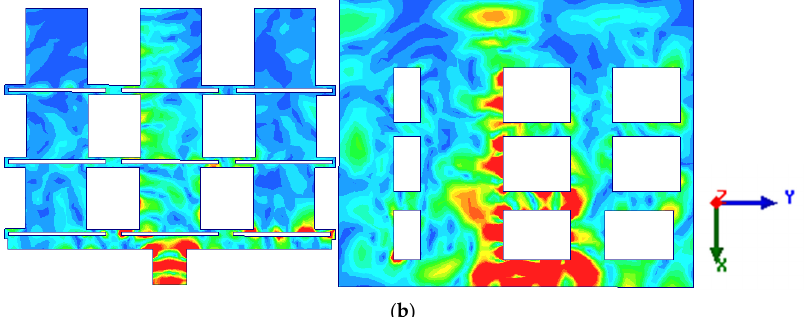
Figure 14. Surface current distribution plots for frequencies ( a ) 22.7 and ( b ) 34.9 GHz.